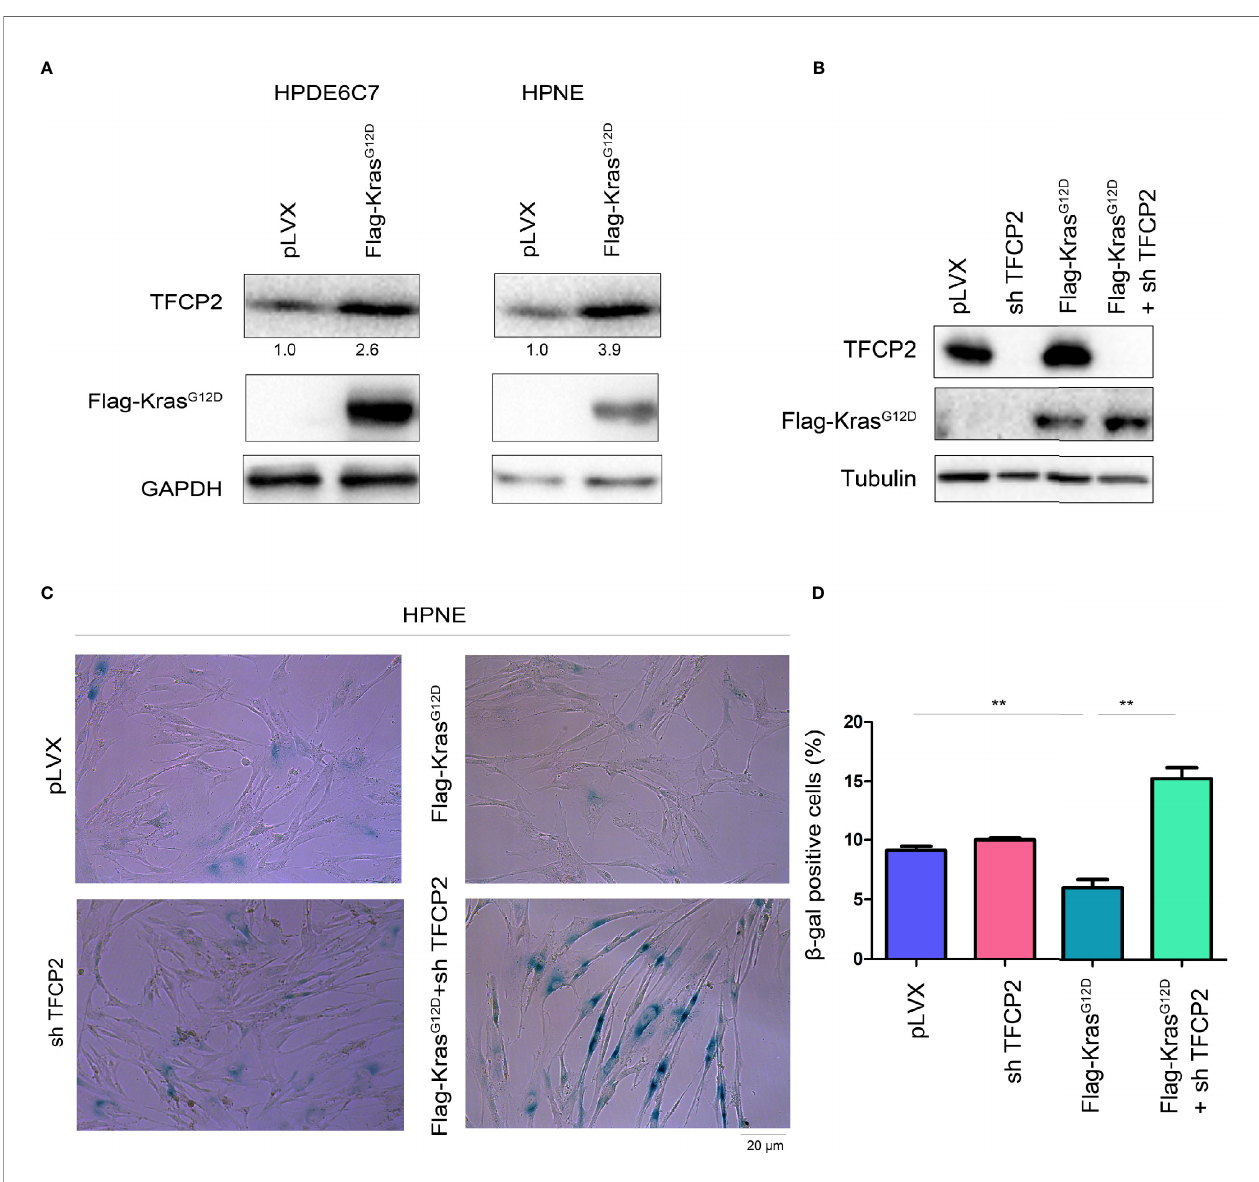
FIGURE 4 | TFCP2 was essential for the Kras G12D to bypass the senescence of pancreatic cancer cells. (A) Western blot was performed to examine the protein levels of TFCP2 in the pancreatic cancer cells. (B) Western blot was performed to examine the protein levels of TFCP2 and mutant Kras. (C, D) b -Gal staining was performed to examine the senescence. Statistical analysis was performed. ** P <